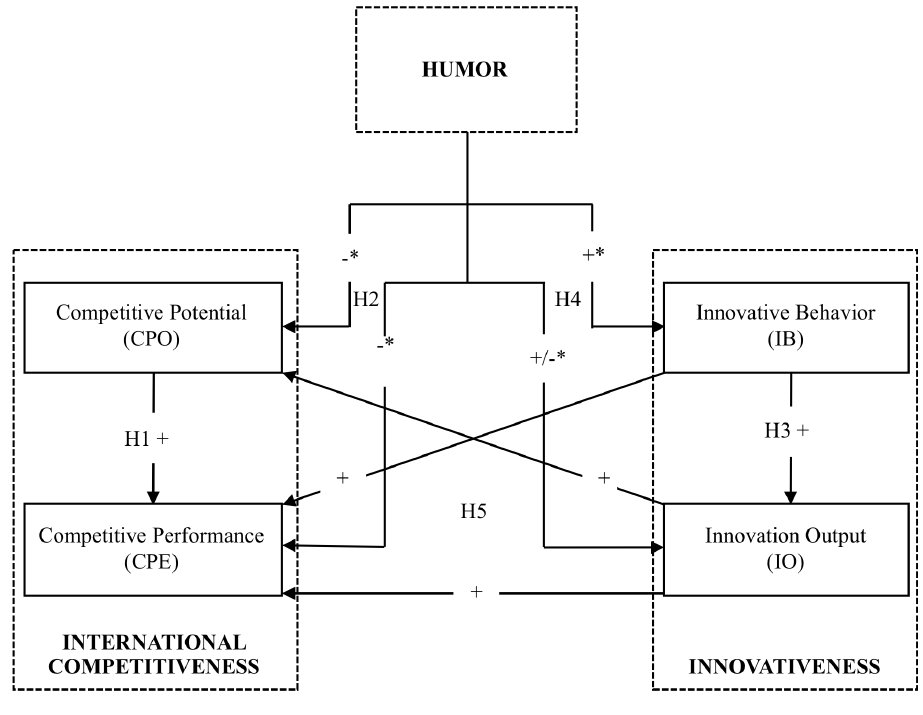
Fig. 2. The relationships between humor, international advancements, and innovation proces-